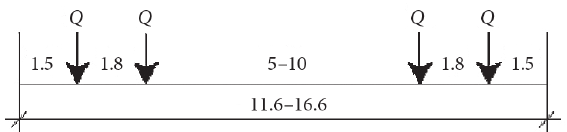
Fig. 8. Equivalent Freight Train according Sustainable